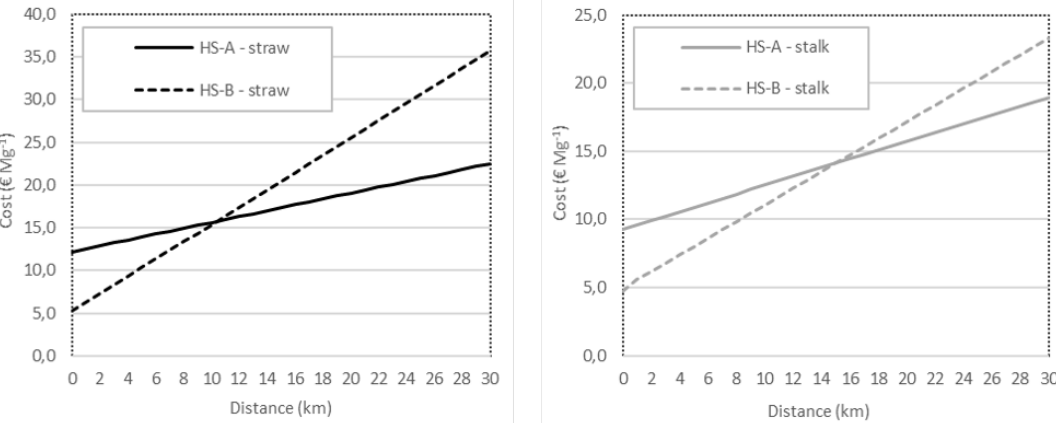
Figure 4. Economic thresholds of the transport of wheat straw and maize stalks by the use of harvesting system “A” (HS-A) and harvesting system “B” (HS-B) in Spain. system “A” (HS-A) and harvesting system “B” (HS-B) in